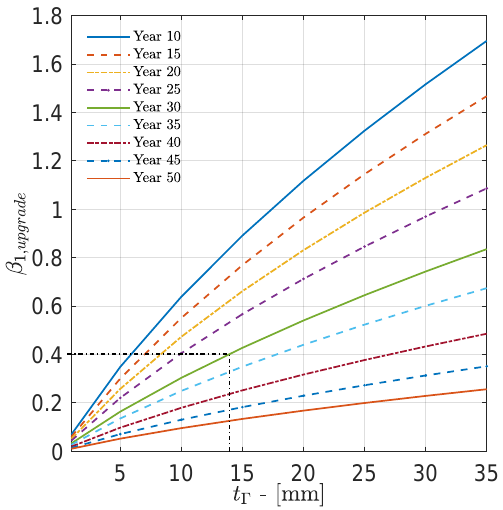
Figure 4. Required upgrading reliability increase β 1 ,upgrade as a function of the thickness of the UH- PFRC layer t Γ and the year when the strengthening operation is